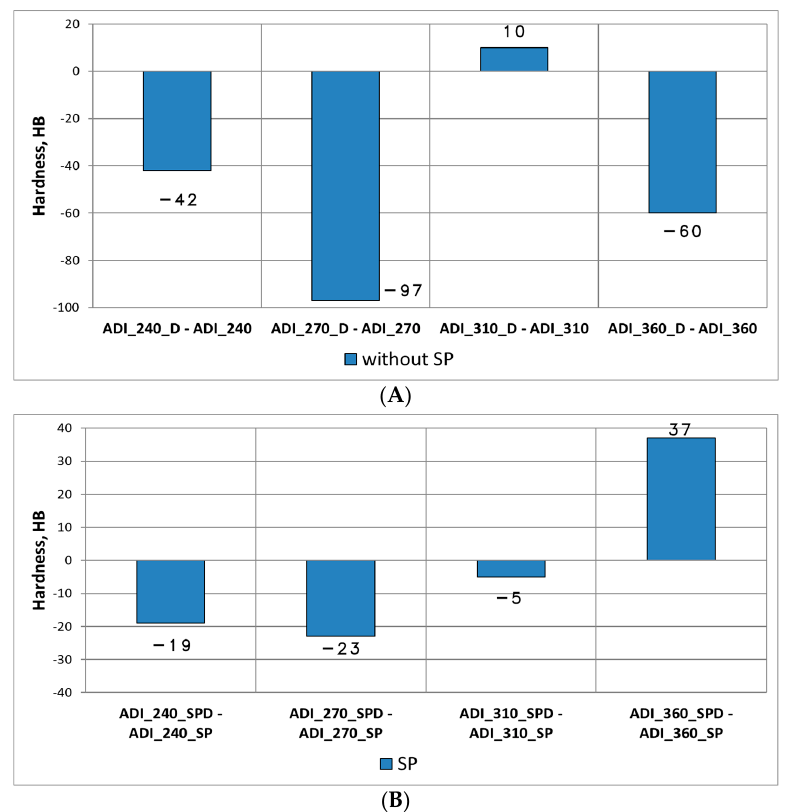
Figure 15. Difference in the hardness of the operating surface layer of wheels made of ADI, formed after the abrasive and abrasive-dynamic wear: ( A ) for the variant without shot peening, ( B ) for the variant with shot peening.